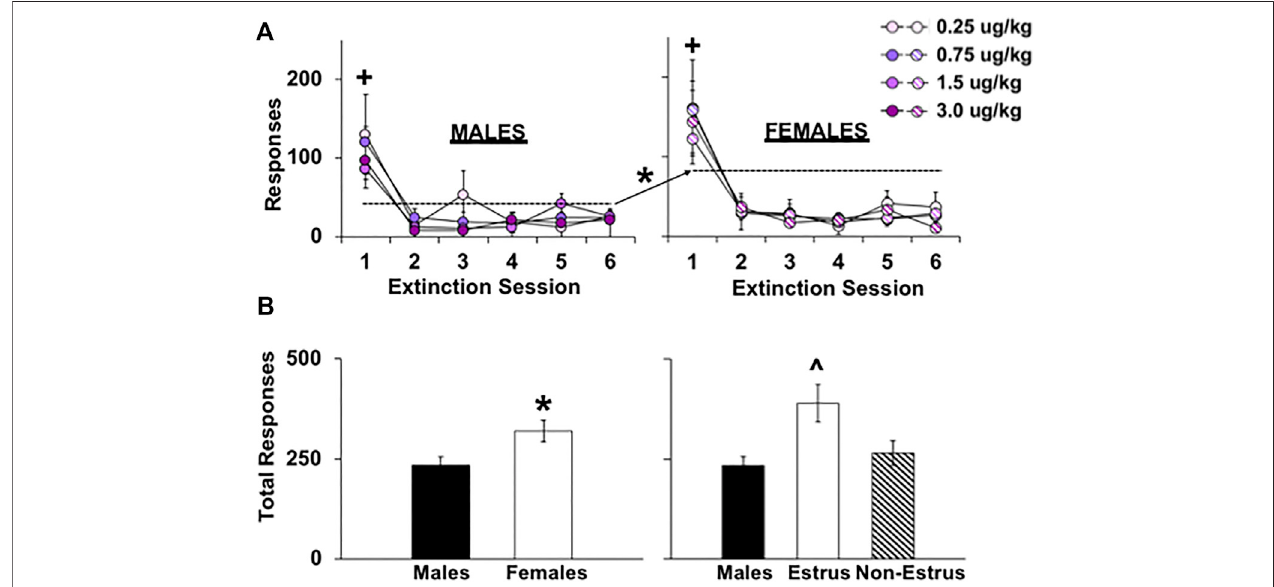
FIGURE4| Effectofsex,estrouscyclephase,anddoseonrespondingduringextinctiontestinginfemaleandmalerats.Mean(±SEM)numberofresponsesmade ontheleverformerlyassociatedwithfentanylduringthe fi rstsix1-hextinctionsessionsformales (A;left) and females(right)withinthe0.25( n = 8males, n = 9females), 0.75 ( n = 8 males, n = 9 females), 1.5 ( n = 8 males, n = 8 females), and 3.0 ( n = 8 males, n = 7 females) dose ( μ g/kg) conditions and across all doses and extinction sessionsrun (B) ( n = 29males, n = 29females). (*) Signi fi cantlyhigher responding in females compared withmales. (+)Signi fi cantlyhigher responding insession1 compared with sessions 2 – 6. ( ^ ) Signi fi cantly higher responding in estrus females compared with non-estrus females and males.